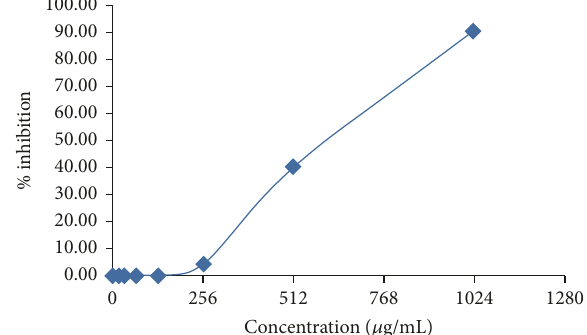
Figure 3: Inhibitory activity of eucalyptus twigs extracts against S. mutans